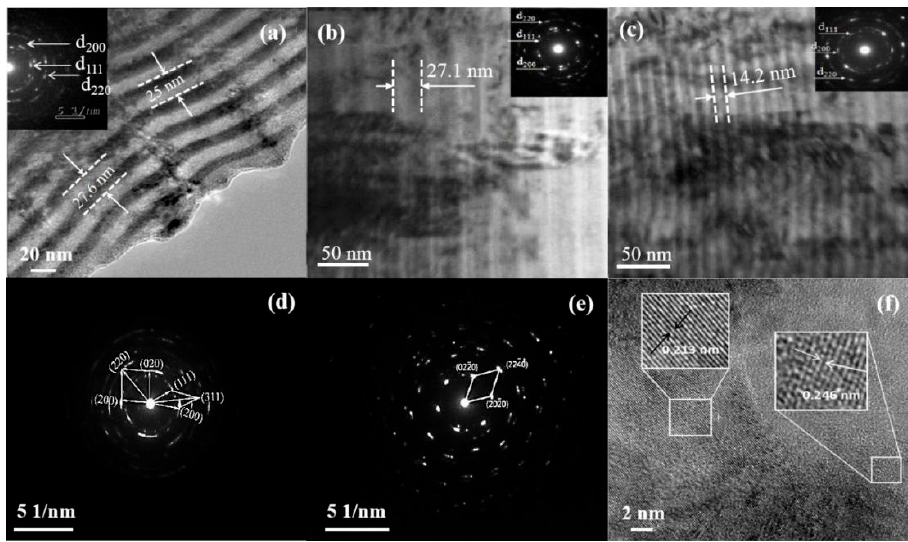
Figure 5. Cross-sectional bright-field HRTEM micrographs of Mo-Ti-Al-N composite coatings: fabricated at 2 rpm with ( a ) high magnification, ( b ) low magnification and fabricated at 3 rpm with ( c ) low magnification, where the upper insets are SAED patterns; SAED patterns of ( d ) B1 TiAlN and ( e ) hcp -MoN; ( f ) higher magnification for 2 rpm sample.